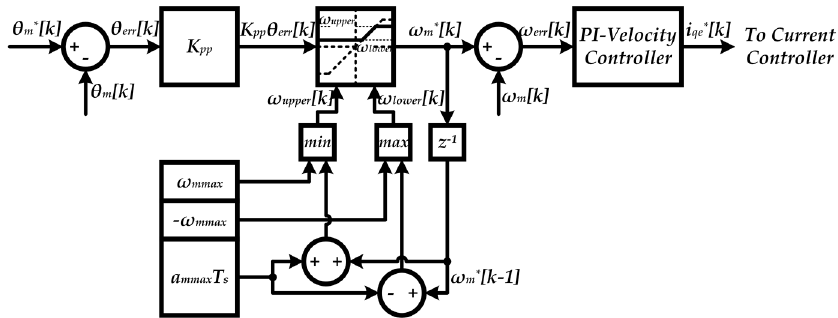
Figure 3. The block diagram of the cascaded P-PI controller on the discretized time base with the dynamic range limiter for the acceleration and velocity limitation.